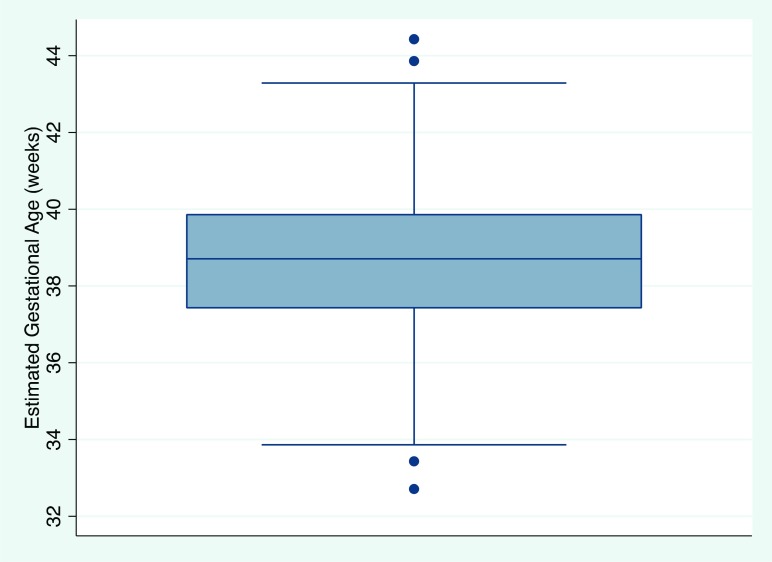
Box Plot With Whiskers of Estimated Gestational AgeaNote: Median gestational age is 38.7 weeks, and the interquartile range is 37.4 to 39.9 weeks.a Gestational age was estimated by centering an infant's height at a z-score of zero on gender-adjusted Fenton growth curves.